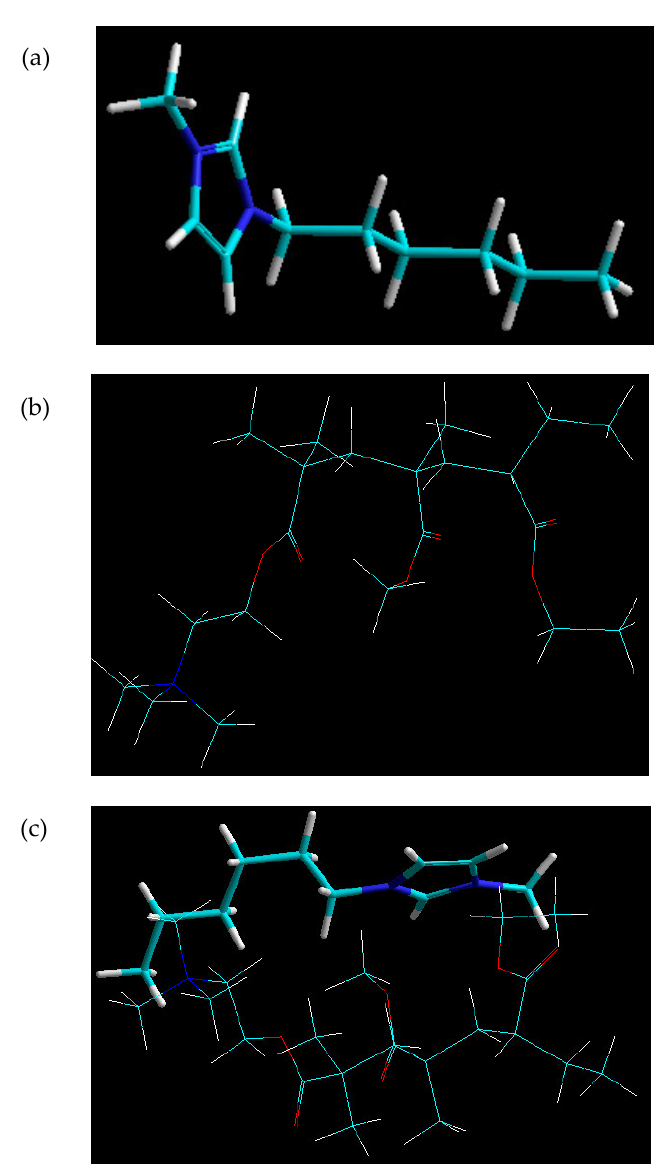
Figure 9. Minimum energy confirmation for ( a ) IL, ( b ) EUD and ( c ) molecular mapping and geomet- rical positioning of IL and EUD after molecular mechanics simulations in a vacuum. Table 3. Molecular attributes for the IL-polymer in silico complex in vacuo.